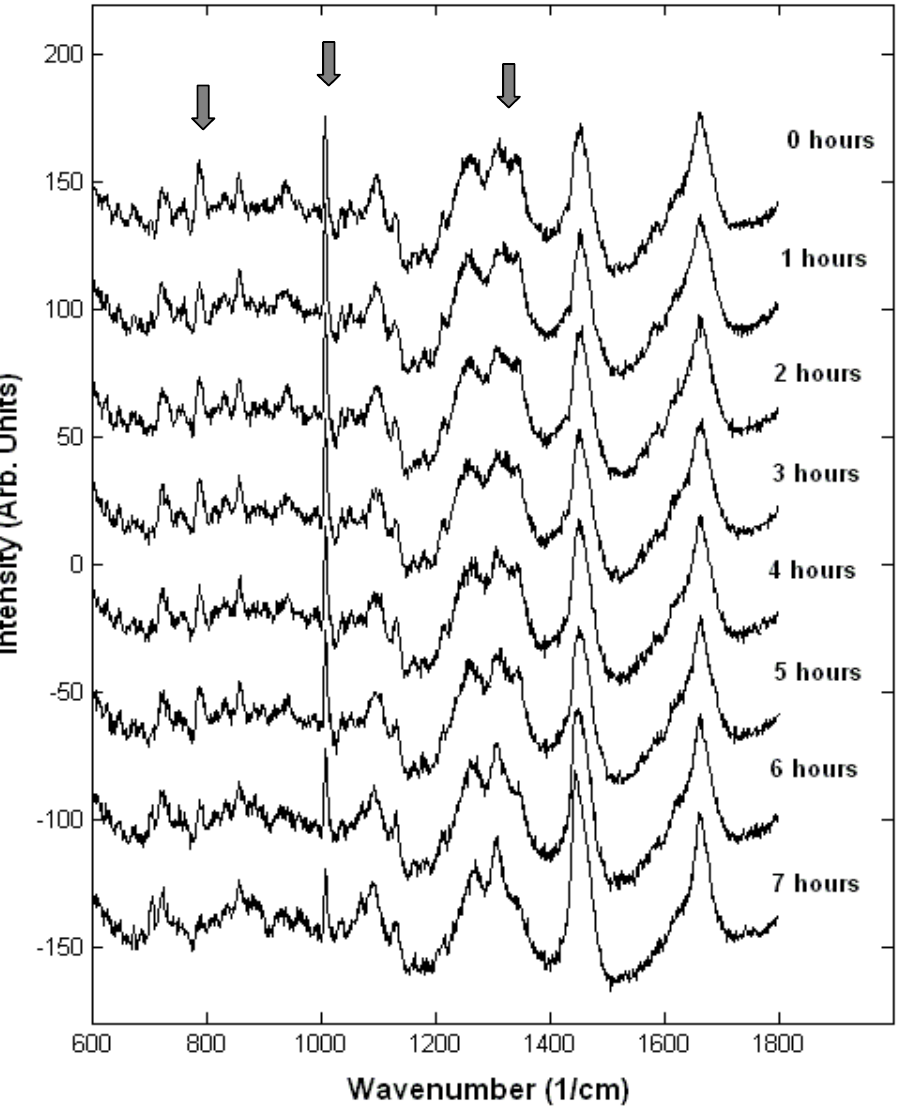
Figure 8 . Monitoring a single A549 cell exposed to Triton X100. The main spectral changes are indicated by the